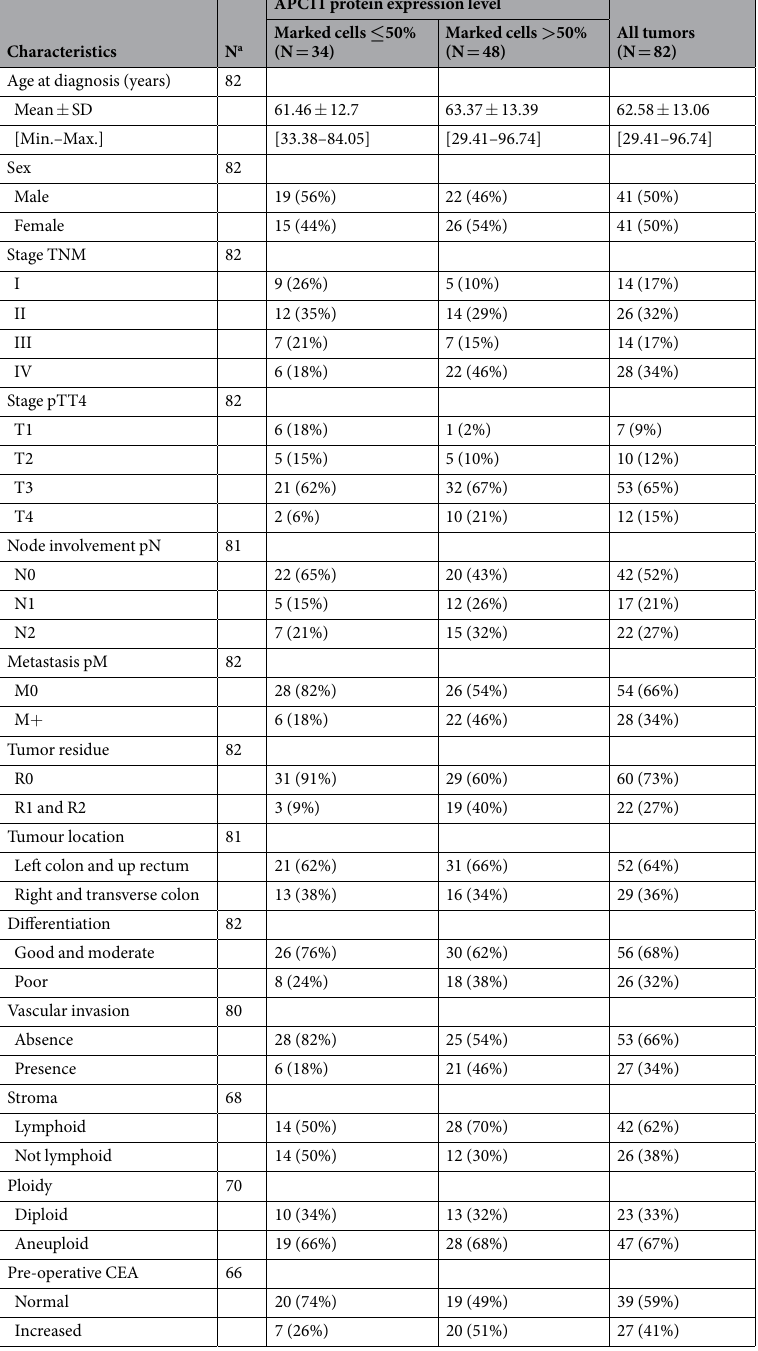
Table 1. Clinical and histopathological characteristics at diagnosis of our series of 82 patients with colorectal cancer, stratified by APC11 expression level. a Number of patients with available